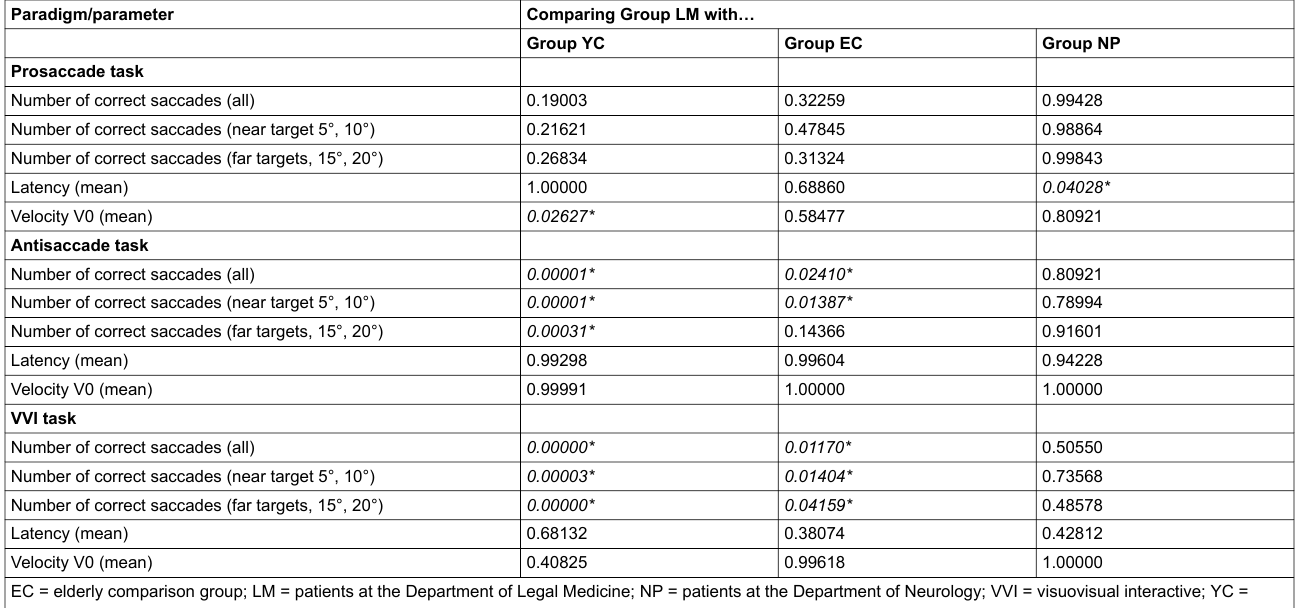
Table 4: Summary of analysis of variance (Scheffe’s post hoc test, α = 0.05) for all tasks and all parameters. The table provides p-values for comparison of Group LM with other groups.